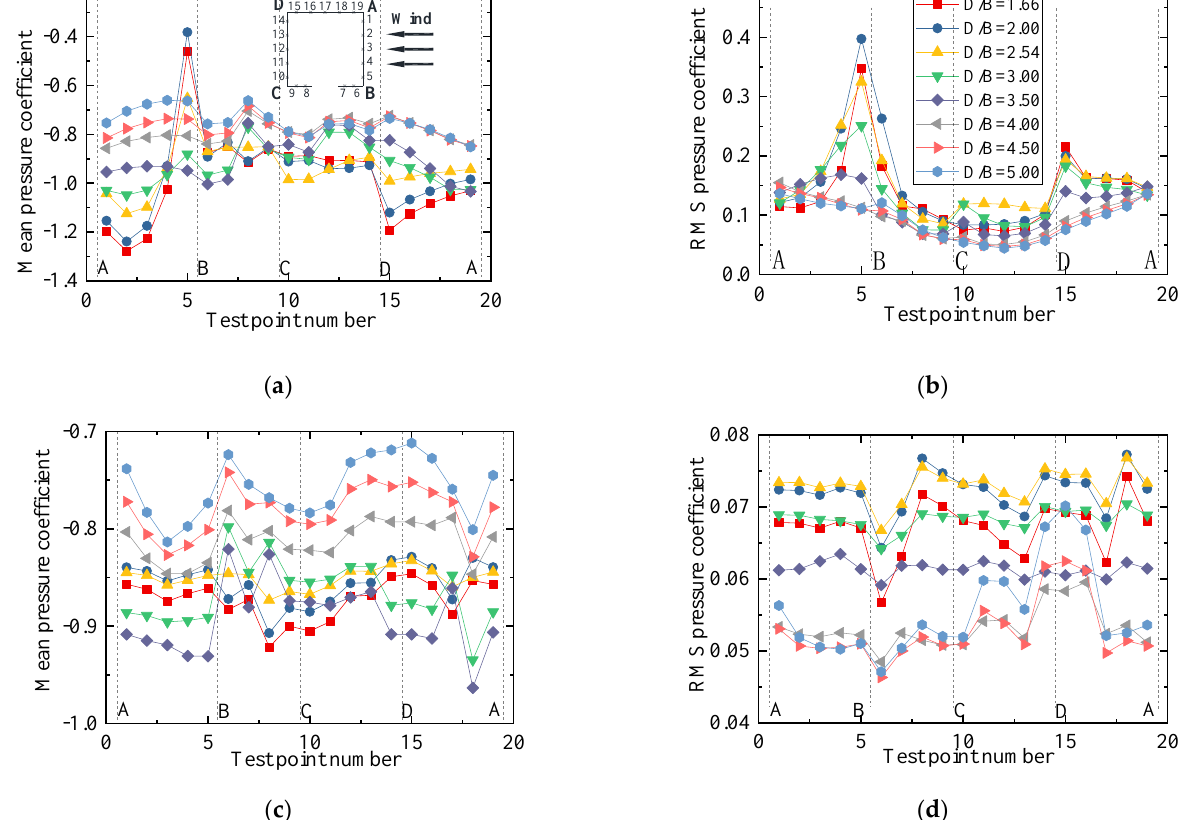
Figure 25. Wind pressure coefficients of the downstream bridge for Case 4: ( a ) Mean values of the outer taps; ( b ) RMS values of the outer taps; ( c ) Mean values of the inner taps; ( d ) RMS values of the inner taps.